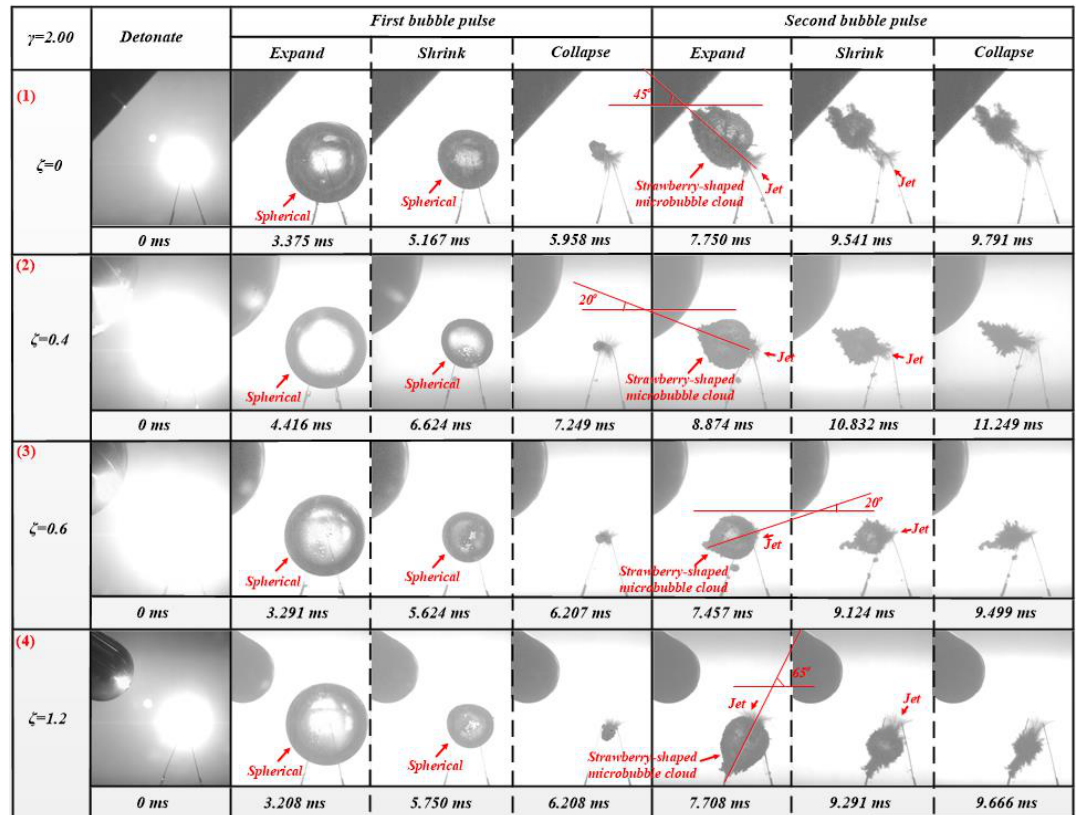
Figure 16. Type VI bubble pulsation process diagram. ( 1 ) The bubble pulsation process when ζ = 0 and γ = 2.00. ( 2 ) The bubble pulsation process when ζ = 0.4 and γ = 2.00. ( 3 ) The bubble pulsation process when ζ = 0.6 and γ = 2.00. ( 4 ) The bubble pulsation process when ζ = 1.2 and γ = 2.00.